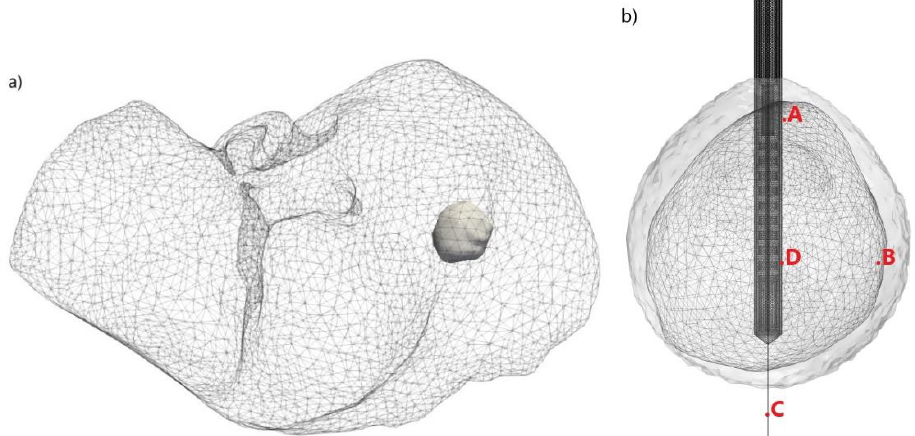
Figure 2. Three-dimensional ( a ) simulation model of the liver (triangulated surface) and an early-stage HCC (solid surface) corresponding to patient 16 in the 3D-IRCADb-01 database [70] and ( b ) configuration of the antenna inserted into biological tissue and positions of four test points (A, B, C, D).